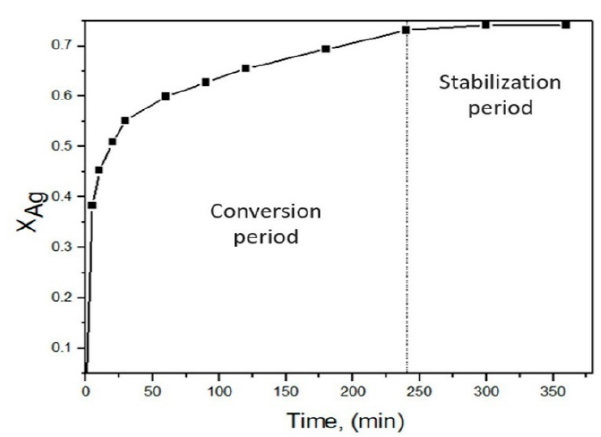
Figure 5. Dissolution curve of silver in the S 2 O 32 − -Cu 2+ system (V = 0.5 L, 40 g L − 1 Mineral, PO 2 = 1 atm, pH = 10, leaching time = 360 min, [S 2 O 32 − ] = 0.16 mol L − 1 , [Cu 2+ ] = 0.006 mol L − 1 , 298 K (25 °C), RPM = 750 min − 1 ).